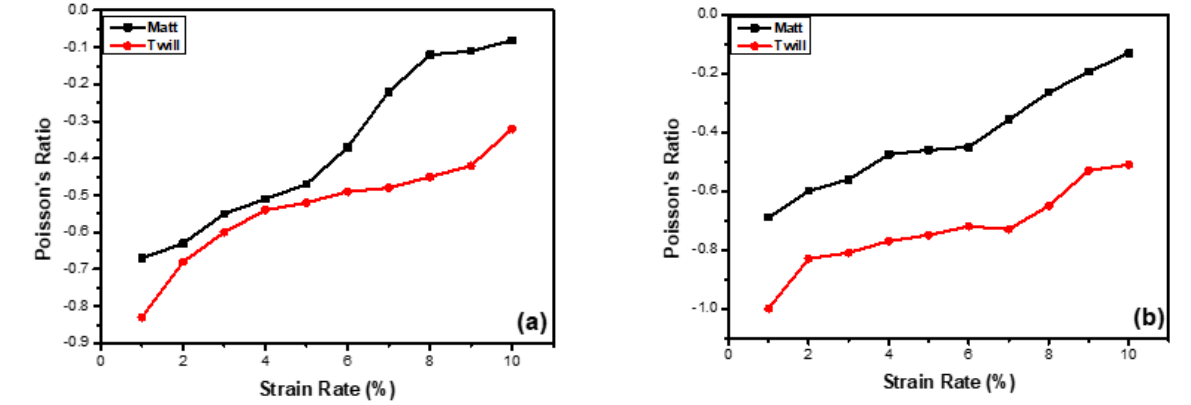
Figure 9. Comparison of in-plane NPR for both fabrics, ( a ) warp-wise, ( b ) weft-wise.